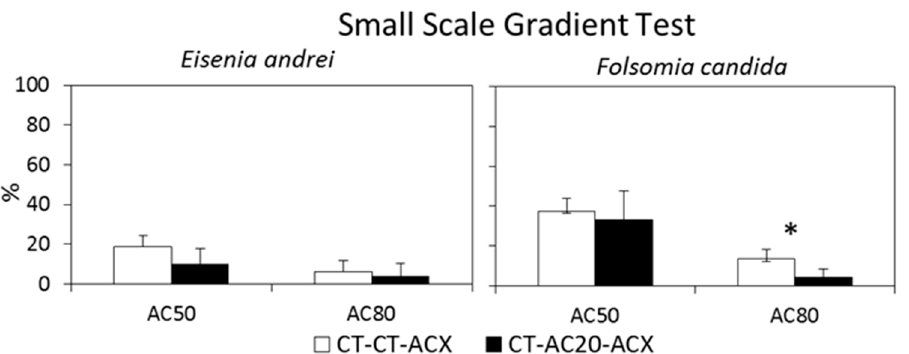
Figure 4. Small-scale gradient tests with Eisenia andrei and Folsomia candida . Percentage of individuals (average ± standard deviation; n = 5) in the section with the highest copper contaminated soil in three compartment test units combining uncontaminated soil (CT) with copper contaminated soils (AC 20 , AC 50 or AC 80 ) using as intermediate concentrations CT (white bars) or AC 20 (black bars) concentrations. * indicates a significant difference between combinations with and without an AC 20 intermediate concentration ( p ≤ 0.05) after Fisher exact test.